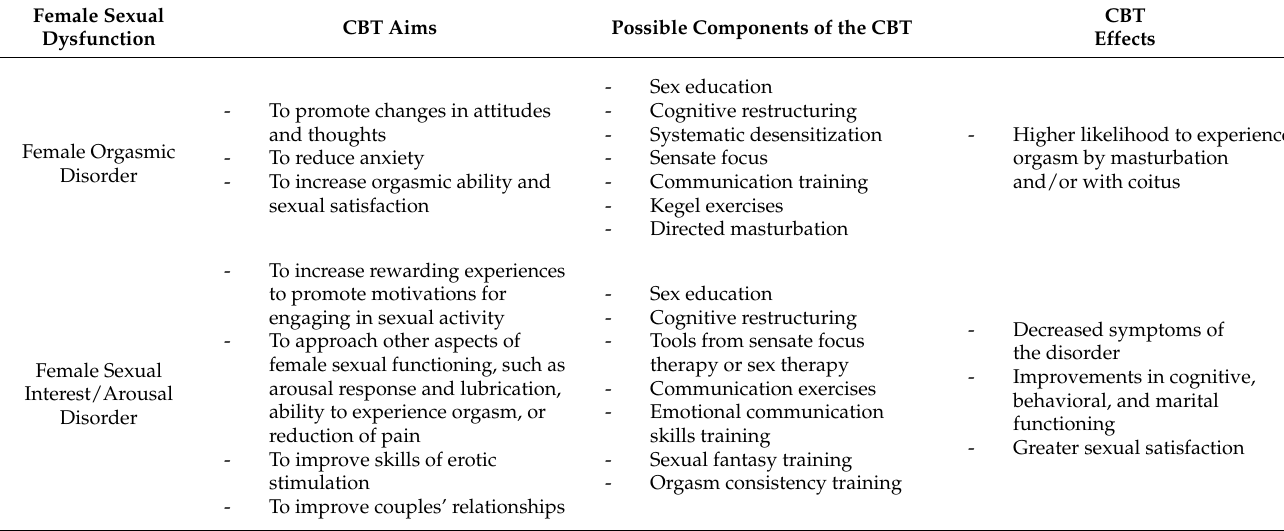
Table 2. Female sexual dysfunctions and